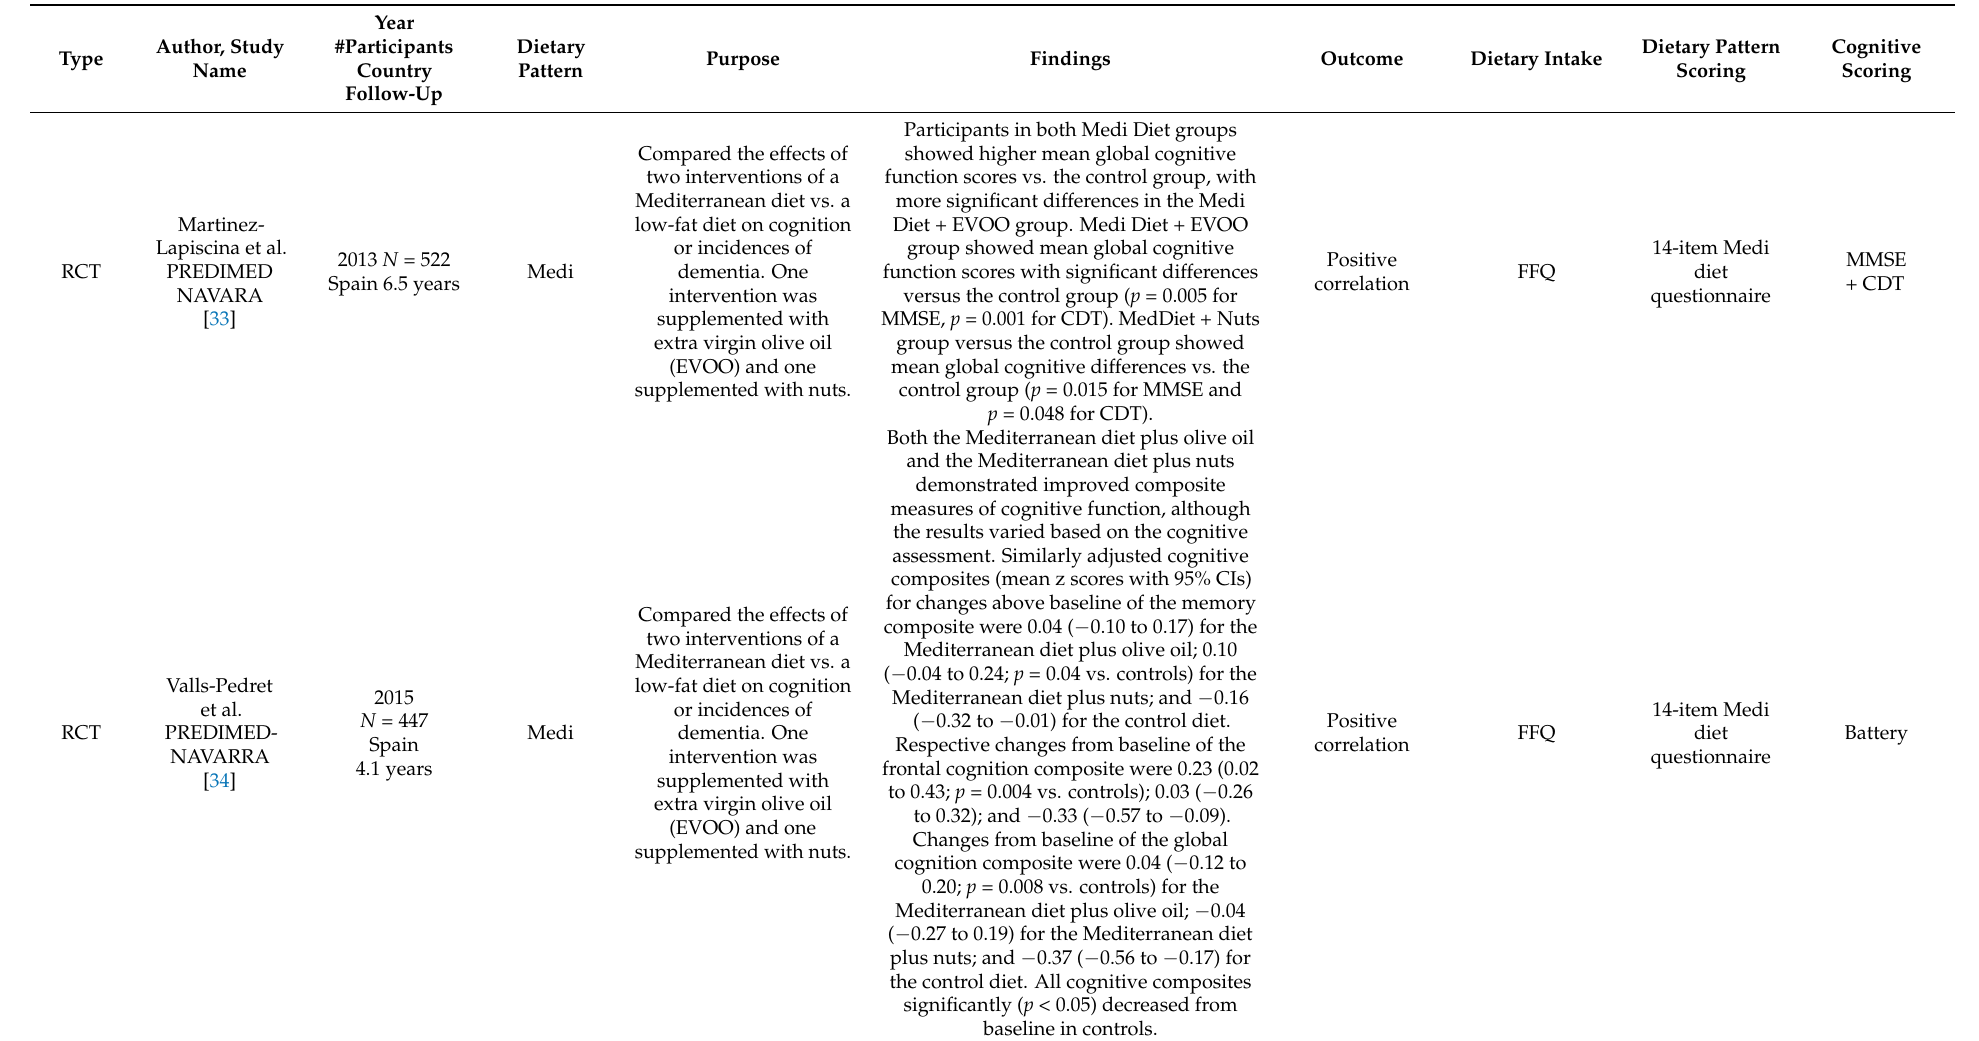
Table 3. RCTs and observational studies in this